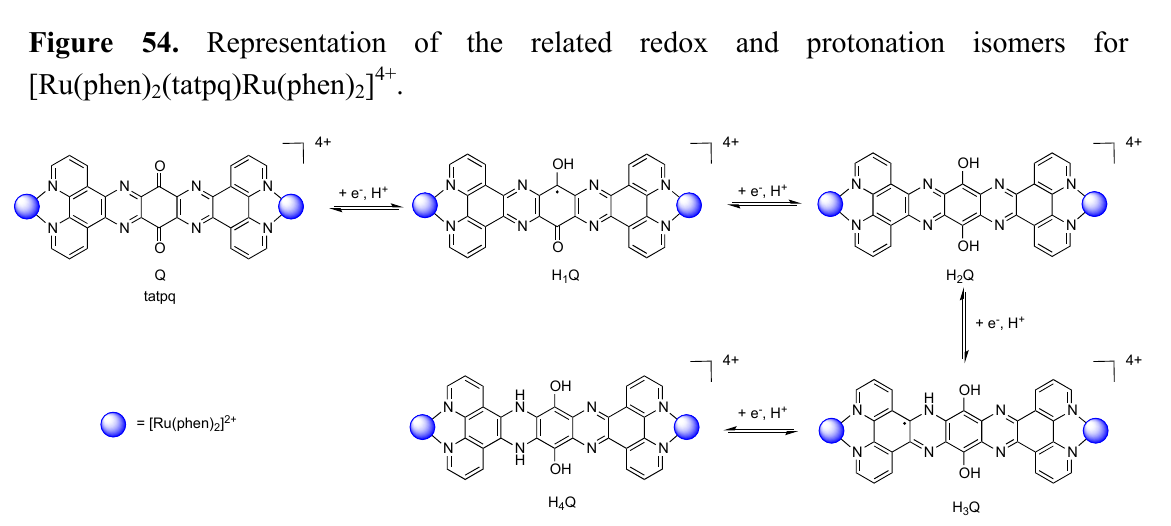
54. Representation of the related redox and protonation isomers